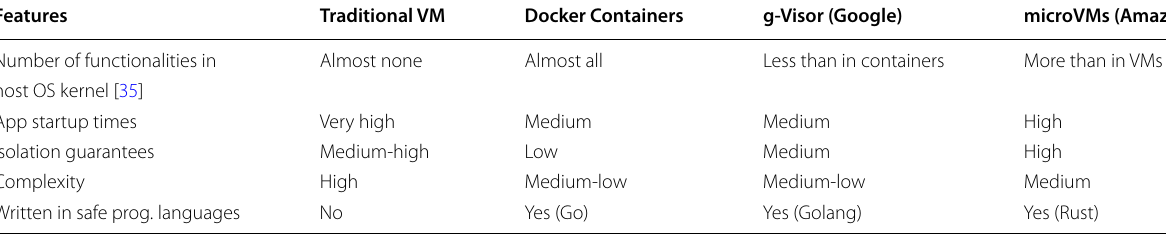
Table 2 Comparison between multiple execution environments